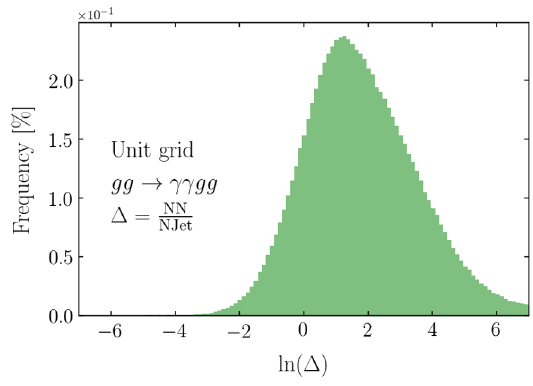
Figure 7. NN/ NJet errors for the 2 → 4 scattering process using a unit integration